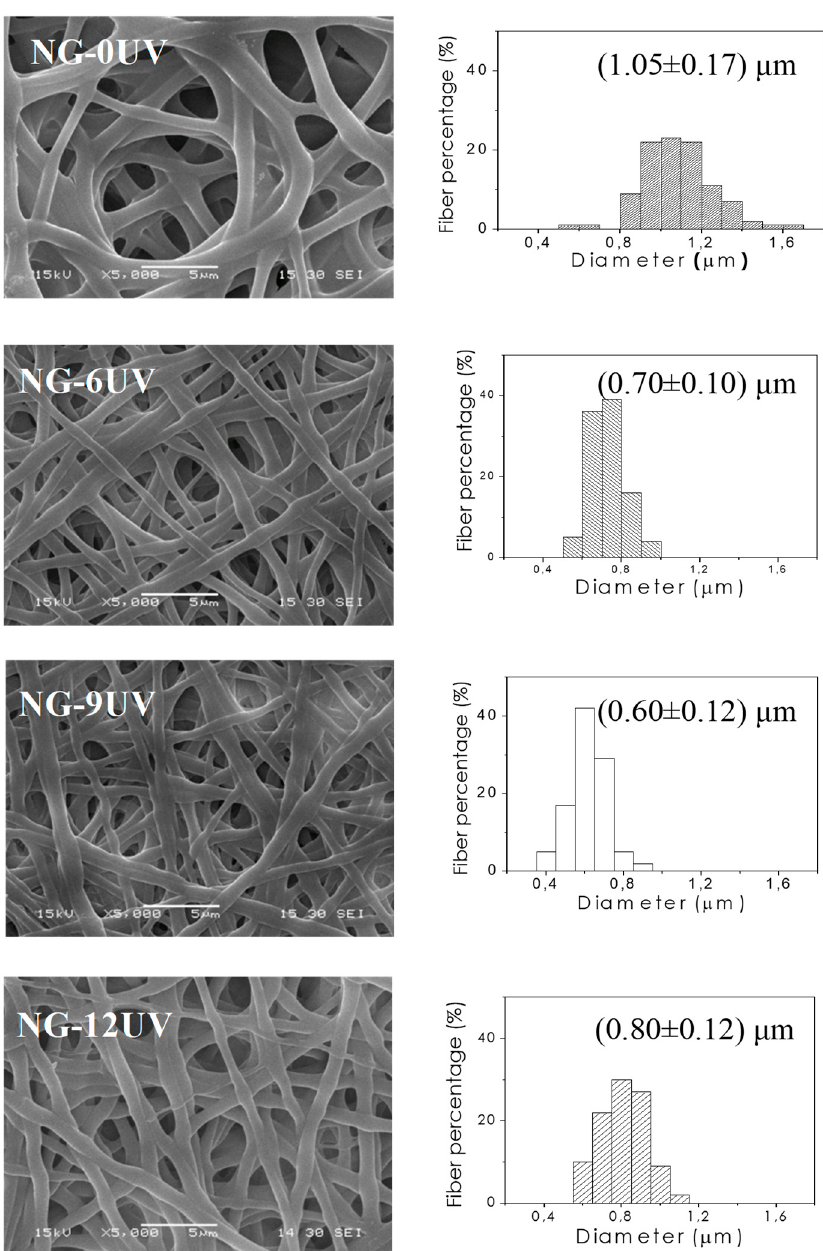
Figure 1. SEM micrographs of samples at different irradiation times: 0 (NG-OUV), 6 (NG-6UV), 9 (NG-9UV) and 12 min (NG-12UV).